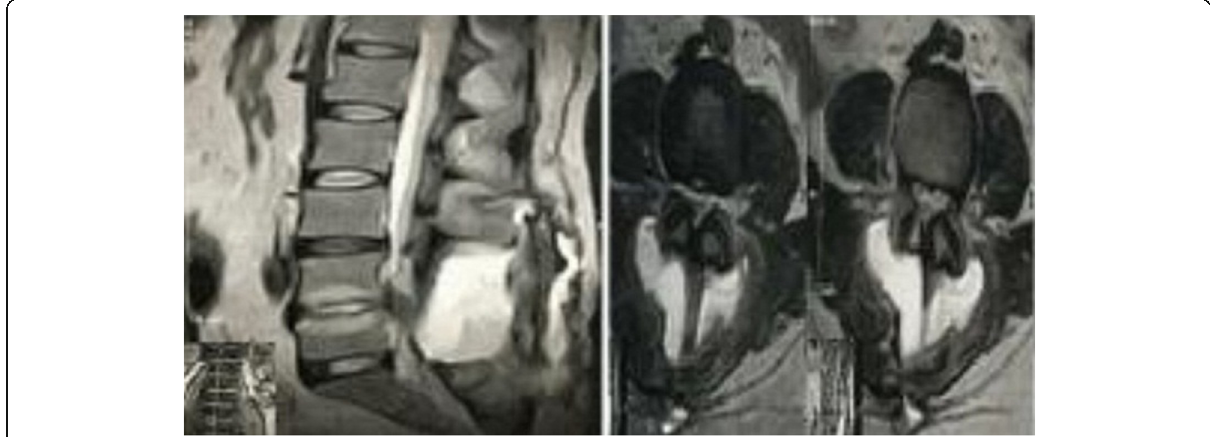
Fig. 2 T2-weighted MRI of a 50-year-old female presenting with iatrogenic L4/5 discitis. Operated upon by debridement and fusion,